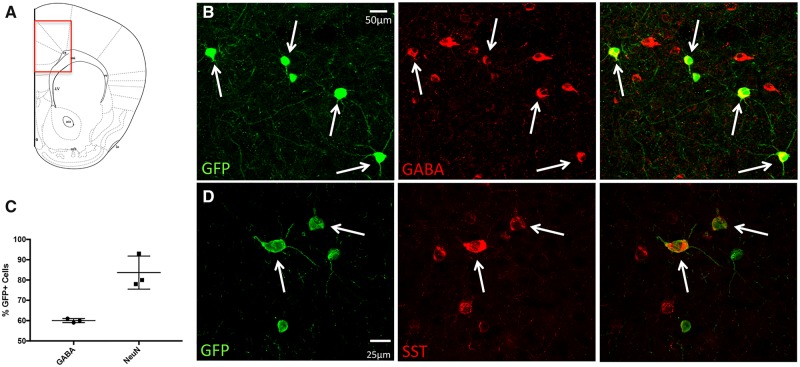

MGE-cell transplants in the ACC of paclitaxel-treated mice. (A) Schematic of MGE transplant location. (B) Thirty days after transplant, GFP+ (green) MGE cells express GABA (red). (C) The majority of transplanted cells are neuronal (NeuN+) and express GABA. (D) Some GFP+ MGE cells co-express somatostatin (SST; red), a marker of a subpopulation of cortical GABAergic interneurons.